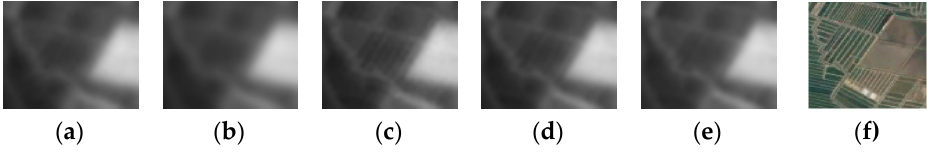
Figure 5. The regions denoted by the rectangles in Figure 5. ( a ) The bicubic upsampled reference image; ( b ) the added image after registration; the HR images reconstructed by ( c ) the proposed method, ( d ) IBP and ( e ) Farsiu’s algorithm; ( f ) the image chipped from Google Earth.